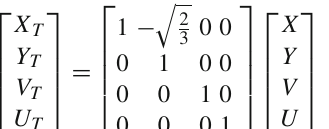
Fig. 1 All possible 3 dimensional phase plots corresponding to the critical point C 0 ( 0 , 0 , 0 , 1 ) for μ > 0; a represents phase plot in xy v -coordinate system (saddle node), b represents phase plot in y v u - coordinate system (unstable node), c represents phase plot in xyu -